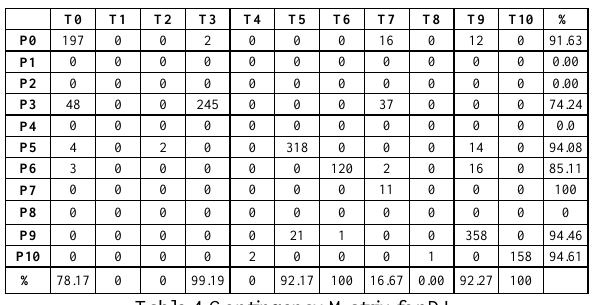
Table 4 Contingency Matrix for DL